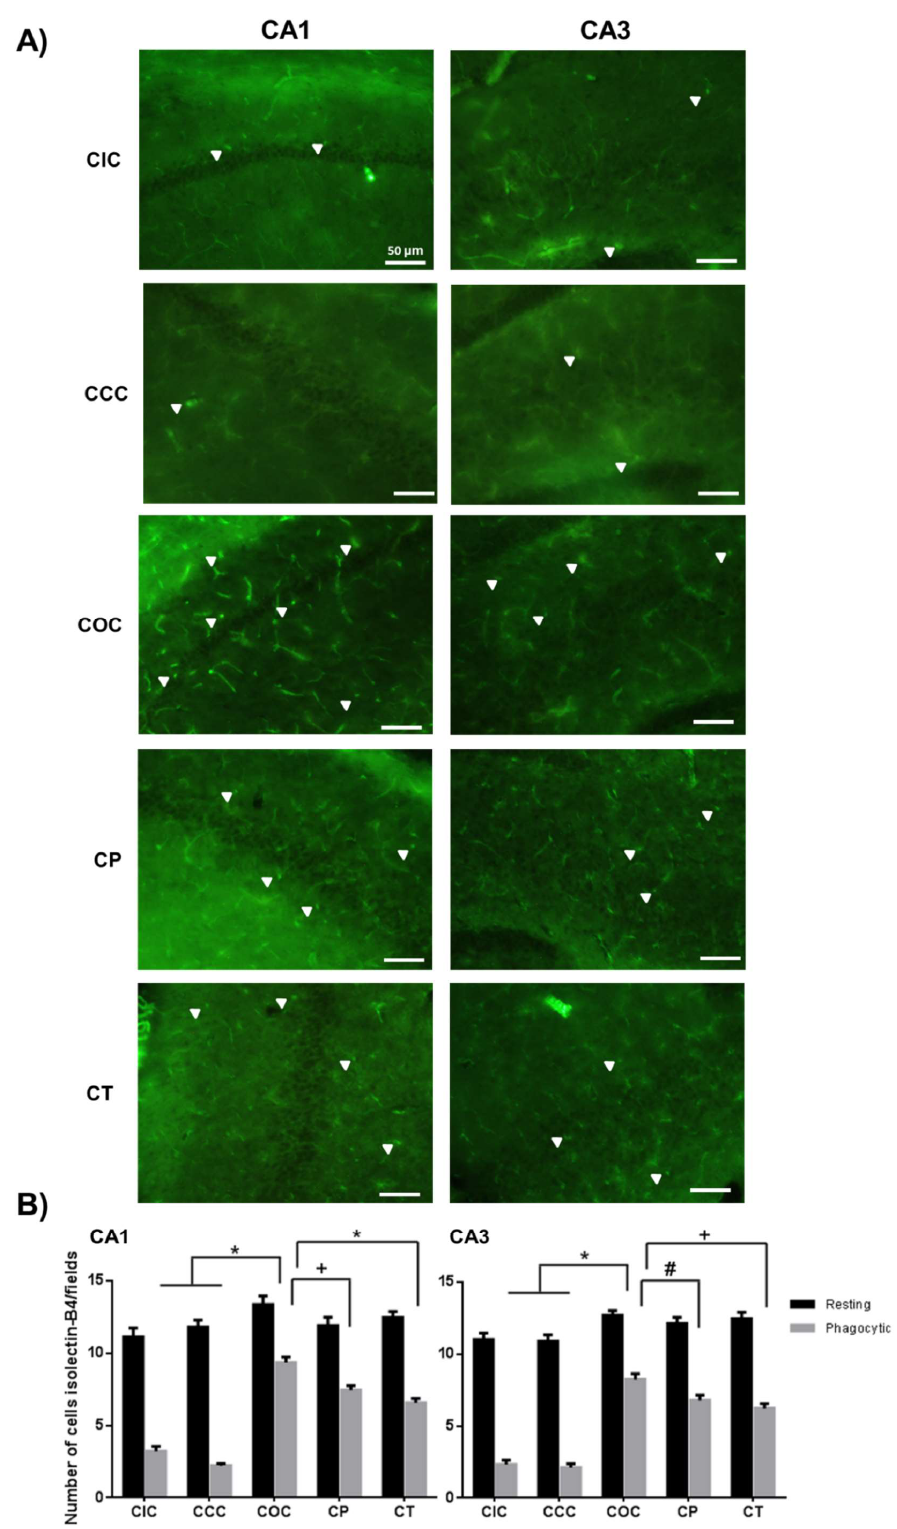
Figure 4. E ff ect of CUR on microglial cell activation in the chronic exposure to O 3 . ( A ) Representative fluorescent photomicrographs show isolectin-B4 reactivity in the CA1 and CA3 regions of the rat hippocampus. The CP and the CT groups showed a significant decrease in the number of activated microglia. Scale bars 50 µ m. ( B ) The total number of isolectin-B4 positive cells are shown in the graph as mean ± SEM and classified according to their morphology. * p < 0.001, + p < 0.01, # p <